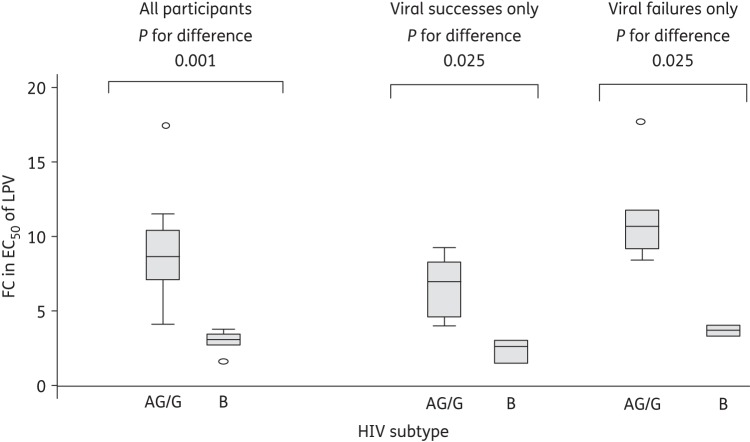
Box plots of phenotypic assay FC in EC50 of lopinavir (LPV) by subtype.